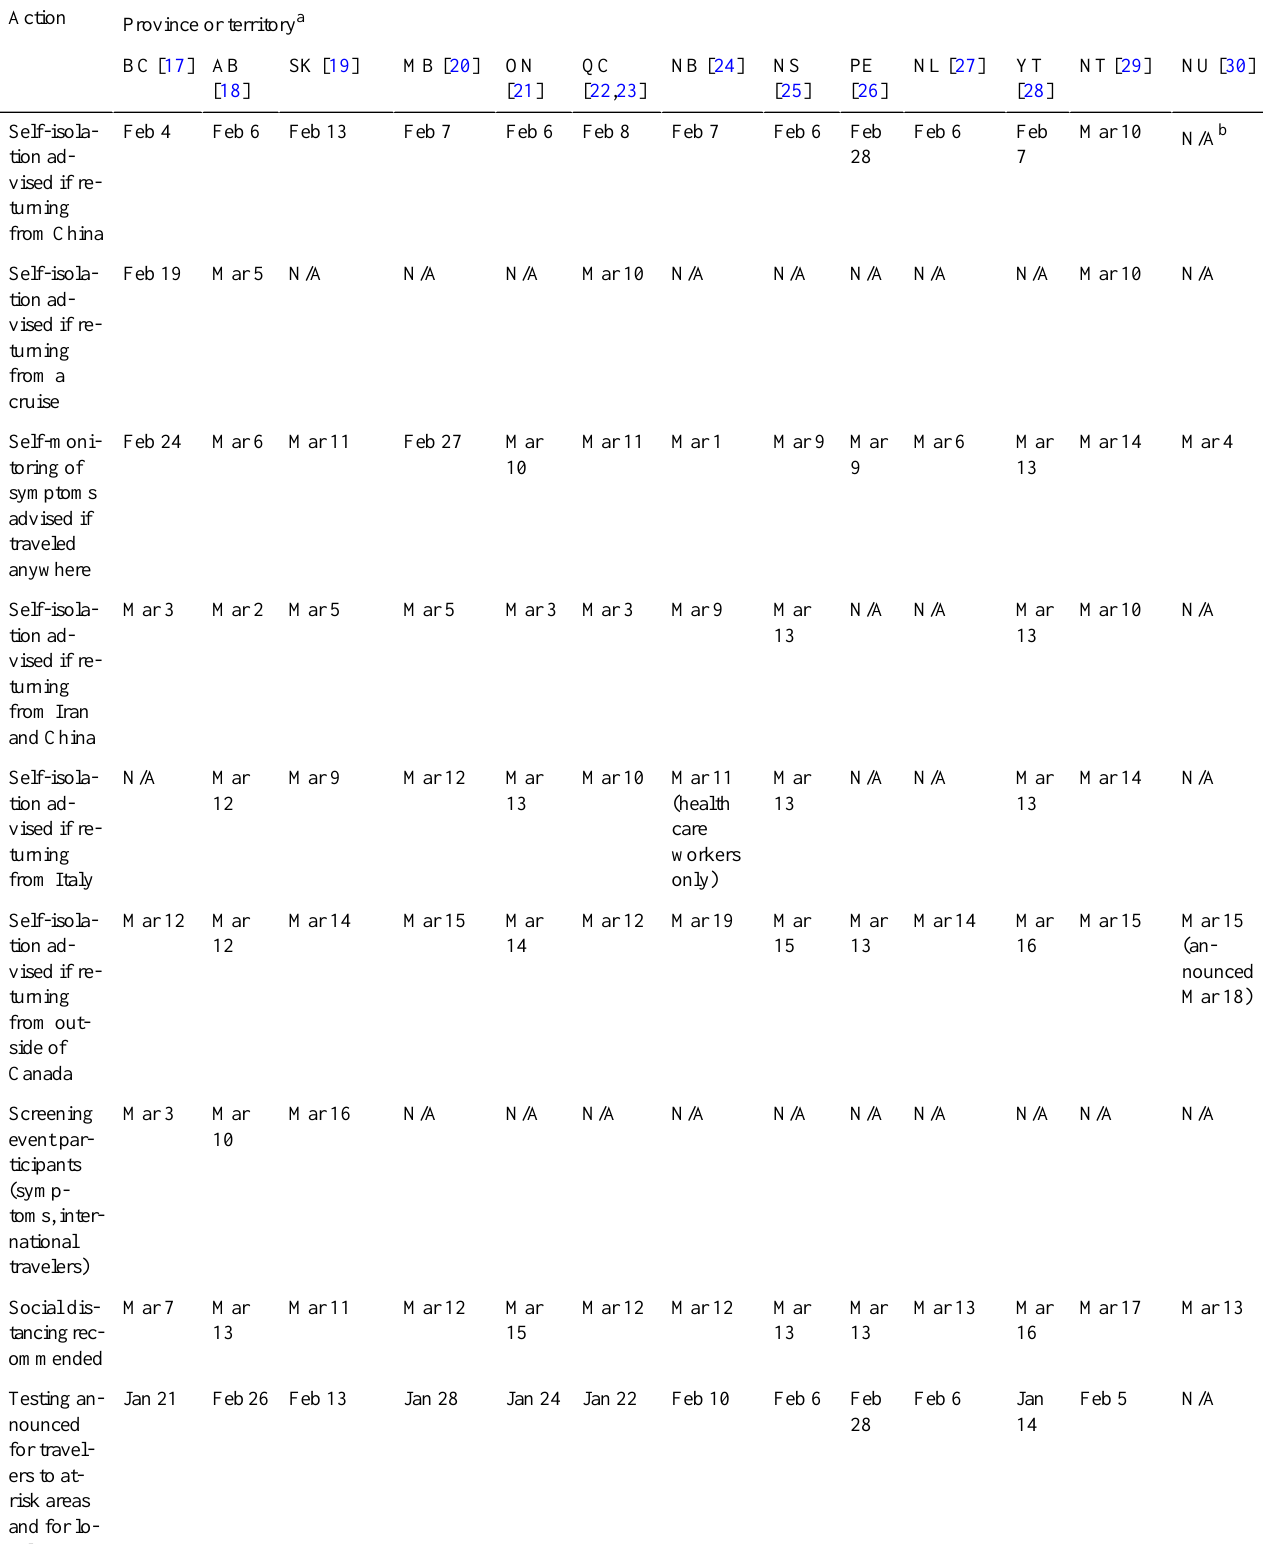
Table 2. Early responses to the COVID-19 outbreak by provincial and territorial governments. Province or territory a